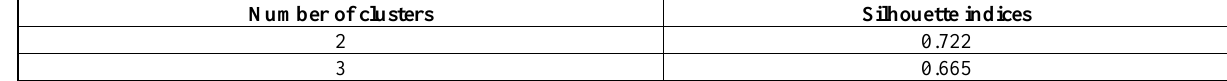
Figure 1. The elbow method used to determine the optimal number of clusters Table 3. Number of clusters and their silhouette indices.